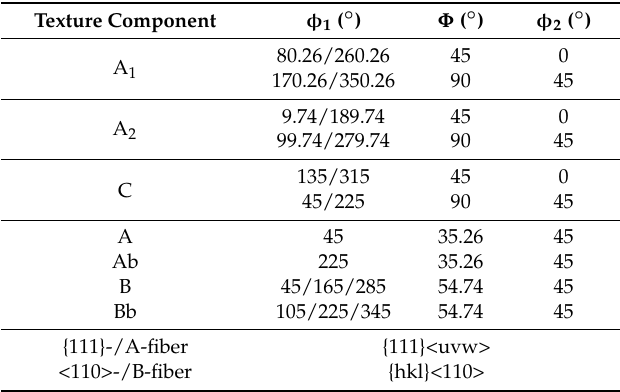
Figure 2. Experimental textures in {111} and {100} pole figures as well as in the φ 2 = 0° ( top ) and 45° ( bottom ) ODF sections. Reference system for the pole figures: vertical axis ( x ) is the outgoing channel axis direction, horizontal axis ( y ) is opposite to the pressing direction, center ( z ) is the transverse direction. The Euler angles of the ODFs refer to the same ( x , y , z ) reference system. The range of φ 1 angle (horizontal axis) is from 0° to 180°, the Φ is from 0° to 90°, in top to bottom direction. Table 2. Definition of the ideal texture components for an ECAP die with 90° angle.